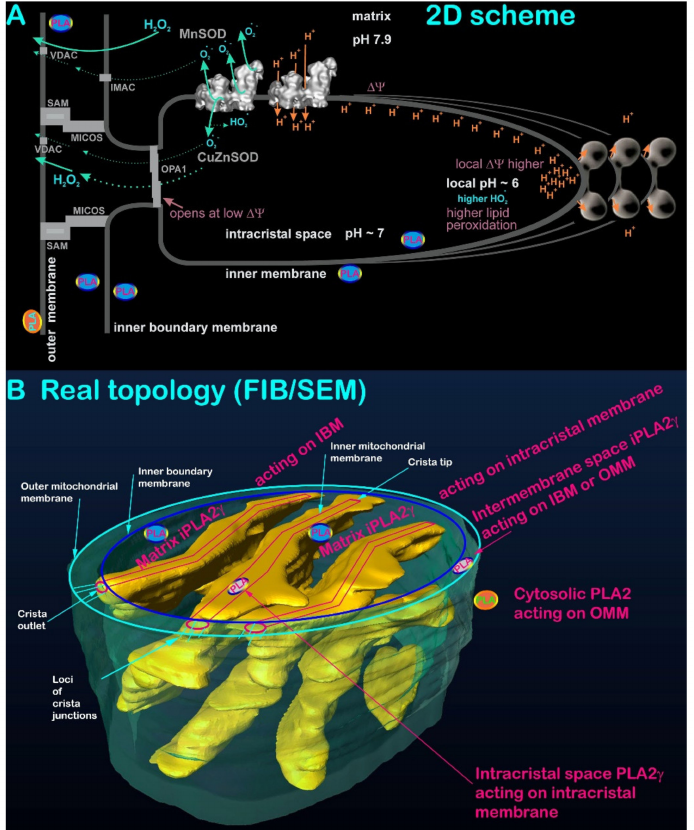
Figure 2. ( A ) Traditional 2D scheme of mitochondrial cristae (modified from Reference [41]) and ( B ) actual 3D topology of cristae within a segment of mitochondrial network tubule (OMM, green) with all possible localizations of mitochondrial phospholipase. The FIB/SEM (focused ion beam/scanning electron microscopy) 3D image of the mitochondrial tubule segment of the mitochondrial network in HepG-2 cells was acquired as described in Reference [42]. The 3D image shows cristae, including the intracristal space as rendered by yellow surface lamellae, representing intracristal membranes (an invaginated IMM portion) together with coated proteins of ATP-synthase and respiratory chain supercomplexes. Red lines illustrate the probable location of the membrane (IMM, not in scale), red ellipses depict the crista outlets, in reality, surrounded by MICOS–SAM joined supercomplexes (cf. Panel A), which are indicated only by thin blue lines. Note that intracristal or intermembrane space location for iPLA2 γ is hypothetical. The latter location must exist if iPLA2 γ participates in remodeling of cardiolipin acyl chains (see Section